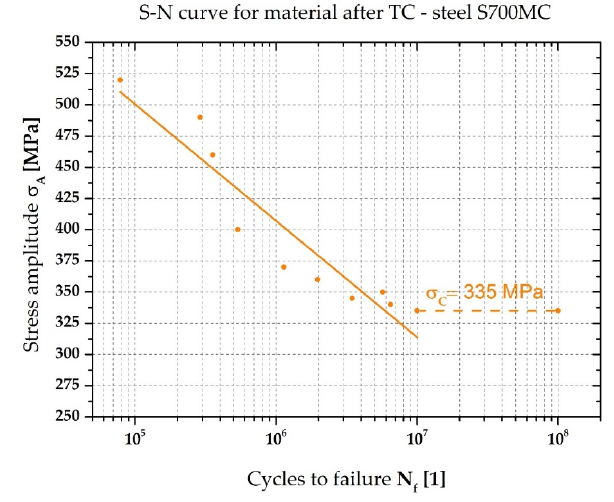
Figure 11. S–N curve of samples with residual stress.